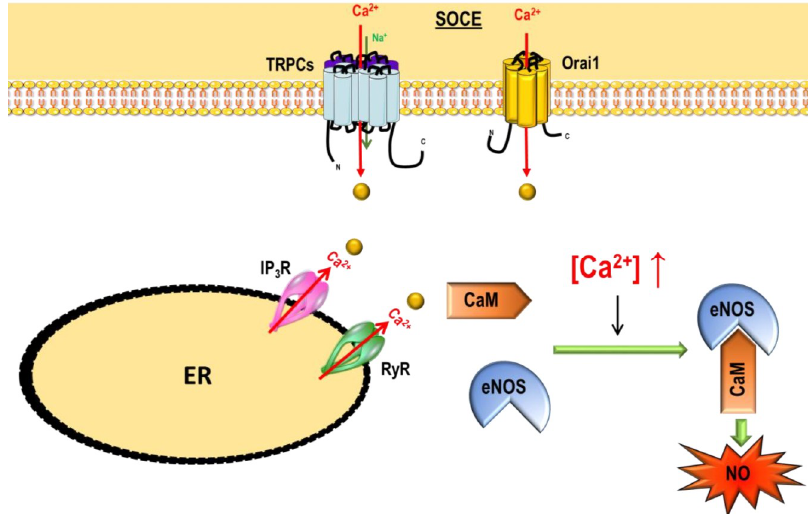
Figure 10. Proposed model of the regulation of eNOS activity and NO production by intracellular Ca 2+ concentration in endothelial cells. Increased intracellular Ca 2+ promotes interaction between calmodulin and eNOS and leads to enhanced eNOS activity and NO production under basal conditions. CaM, calmodulin; eNOS, endothelial nitric oxide synthase; NO, nitric oxide; TRPCs, Transient receptor potentialcanonical; IP3R, inositol 1,4,5-trisphosphate receptor; RyR, Ryanodine Receptors, ER: Endoplasmic reticulum.